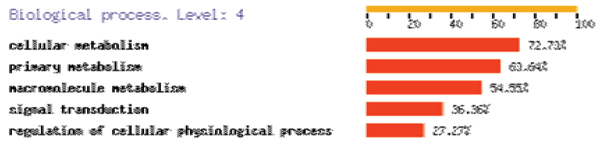
Gene ontology on potential master regulatory region. Overrepresented GO terms by the phenotypes associated to the SNP rs916482 analyzed using FatiGO .